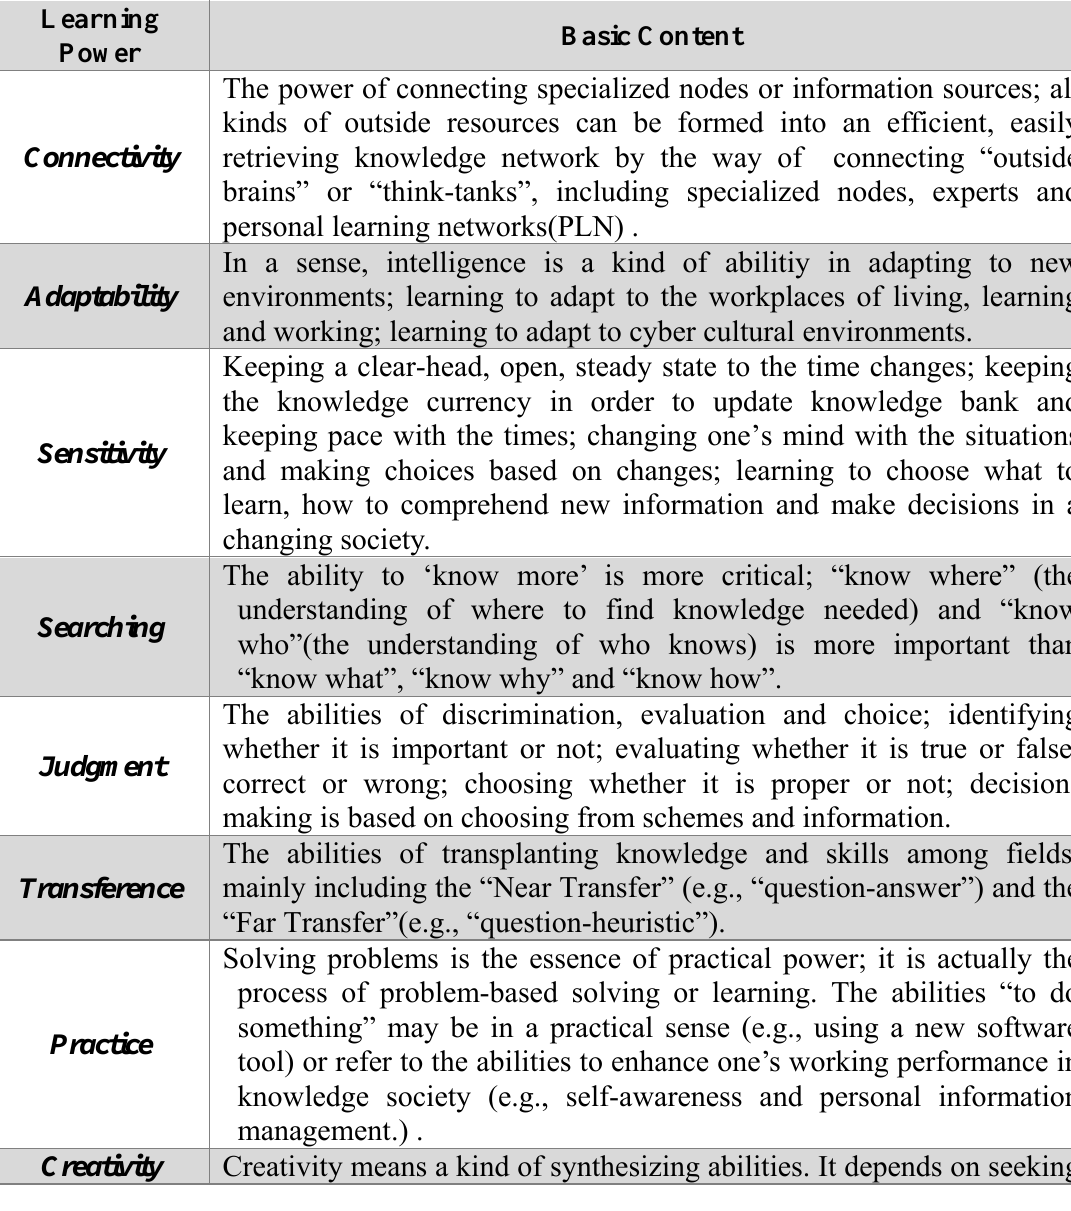
Table 1: Learning Power: a Connectivist